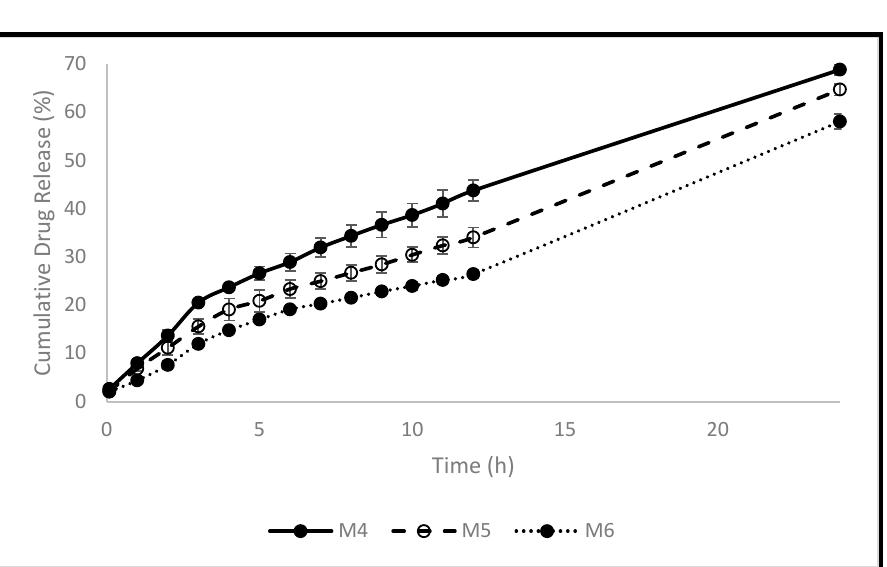
Figure 3. The pellets’ release profiles in PBS. Table 5. The Korsmeyer-Peppas model’s rate constants (k), n-value, and R 2 of the release data.